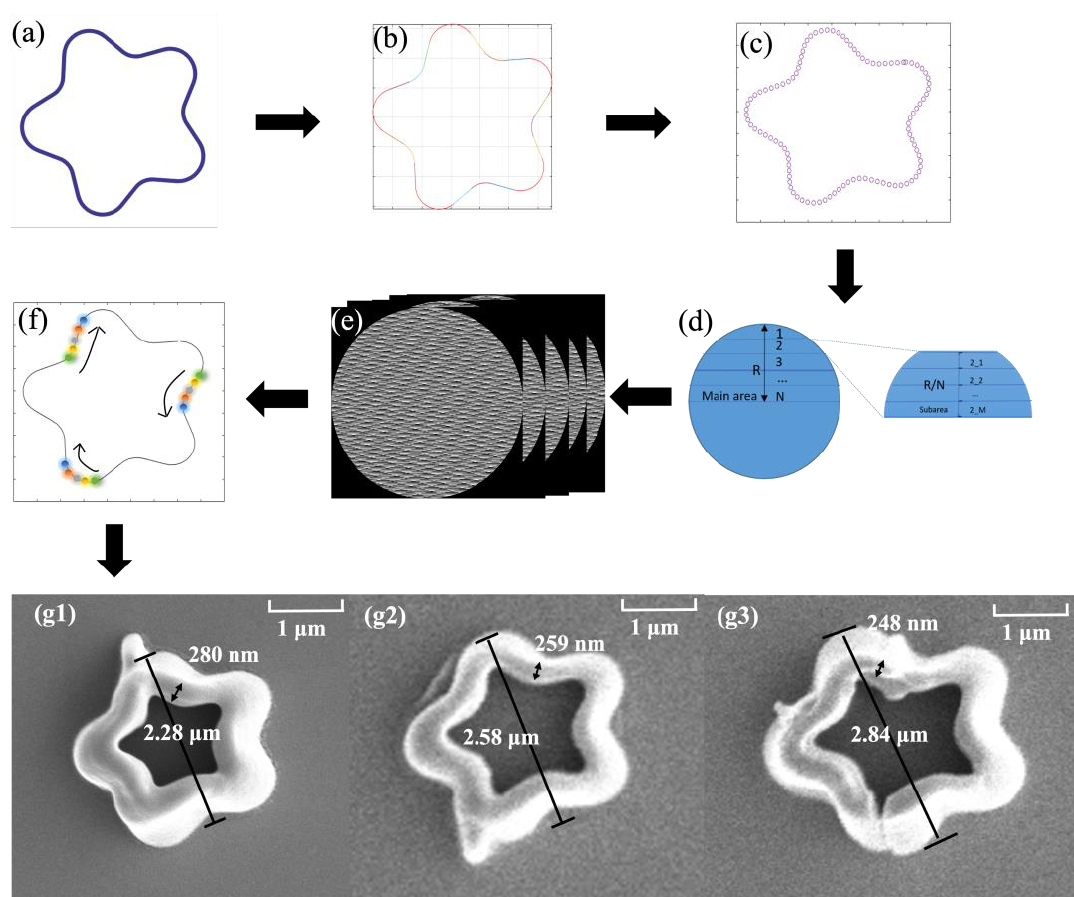
Figure 7. Fabrication of a small – area star structure with three Bessel – Gaussian laser spots. ( a ) Interpret the SVG into mathematical equations, with a star pattern as example. ( b ) Construct the outline of the star. ( c ) Discrete the outline into coordinate points ( Δ𝑥 , Δ𝑦 ). ( d ) The phase maps sequence is generated by the SSP method . ( e ) Generate phase maps with three Bessel – Gaussian laser spots and their movements. ( f ) According to the coordinates through path designing, where the arrows represent the direction of the fabrication path. ( g1 – g3 ) Final fabrication results with three Bessel – Gaussian laser spots. Here, 𝑑 = 0.39 μm and ∆𝑑 = 0.07 μm. The laser power is 10 mW and the exposure time for a single phase map is 17 ms. The sizes of the structures in ( g1 – g3 ) are 2.28, 2.58, and 2.84 μm, respectively.